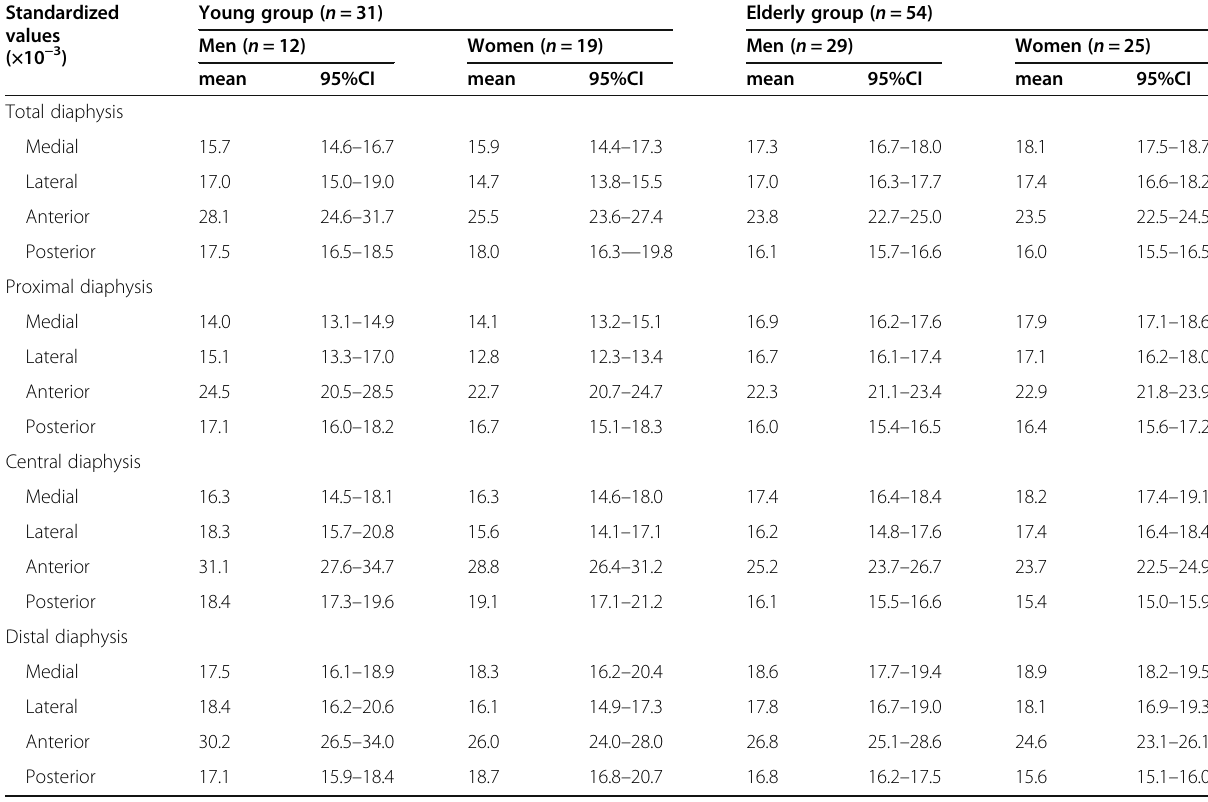
Table 2 Cortical thickness in the tibial diaphysis (standardized values) Standardized values